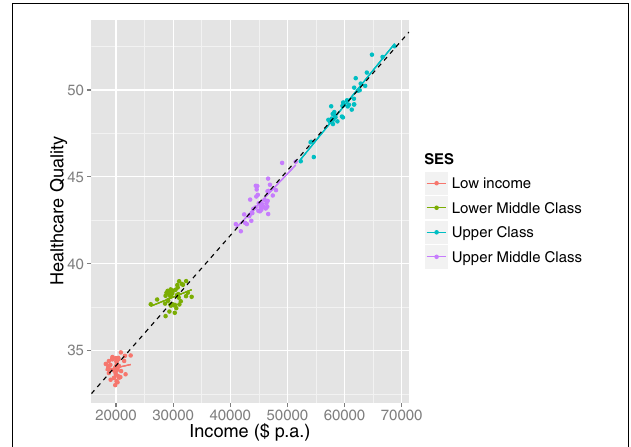
FIGURE 5 | A case when visualizing the data illustrates that although there are separate clusters, the inference is not affected: the relationship between income and healthcare quality is homogeneously positive. The clusters may have arisen due to a sampling artifact or due to naturally occurring patterns in the population (e.g., discontinuous steps in healthcare